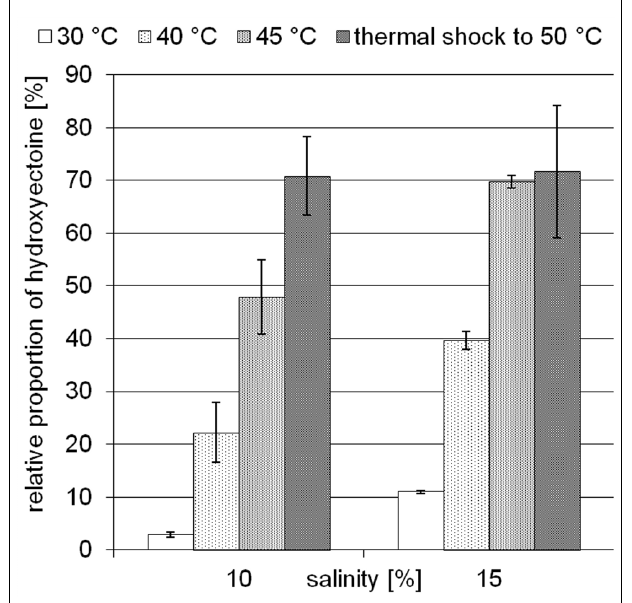
FIGURE 3 | Growth of H. elongata in minimal medium MM63 with 15% sodium chloride. The experiment was performed with two parallel culture, one at constant 30 ◦ C (black dots), the other with a rapid temperature upshock at OD 2 (arrow) from 30 to 50 ◦ C (white dots).The inset shows the relative proportions of ectoines in bacterial cells at the early stationary growth phase (point of harvest).